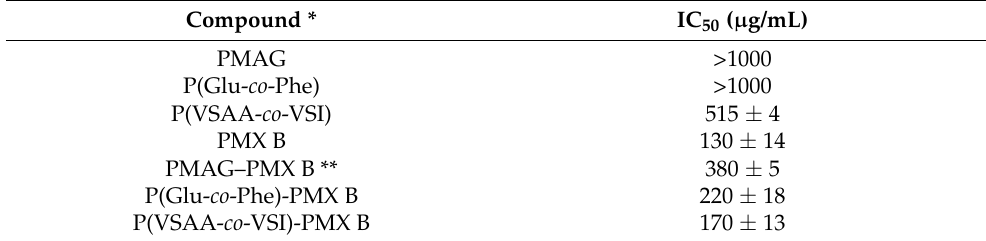
48 h): * conjugates were tested relative to PMX B concentration; ** PMAG − PMX B conjugate was tested with the reduced aldimine bonds. Data are presented as mean ± SD.